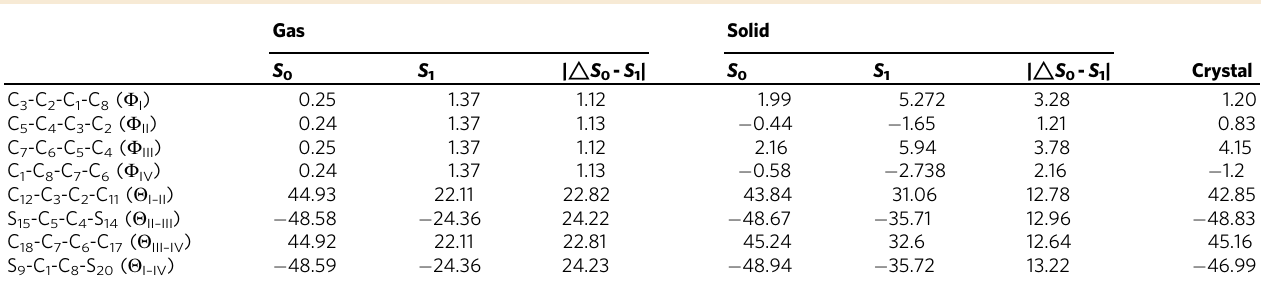
Table 1 Calculation results of COTh in both the gas phase and the crystal